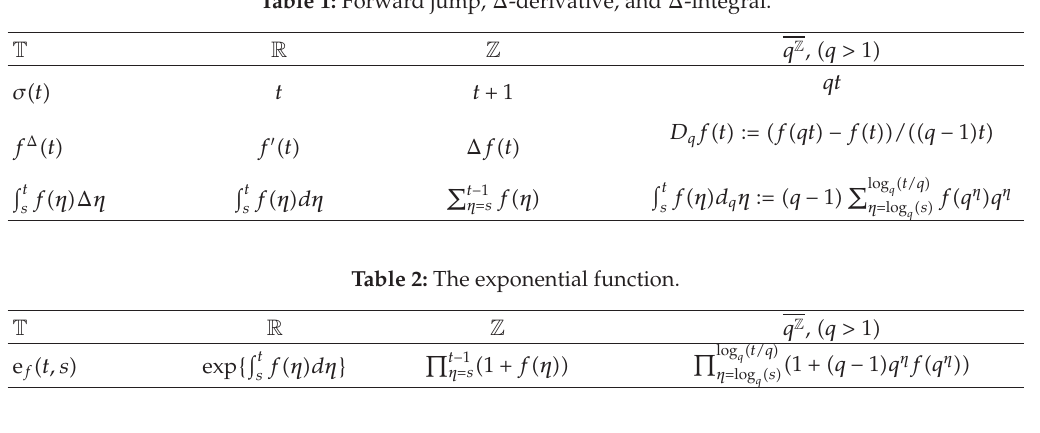
Table 1: Forward jump, Δ -derivative, and Δ -integral.